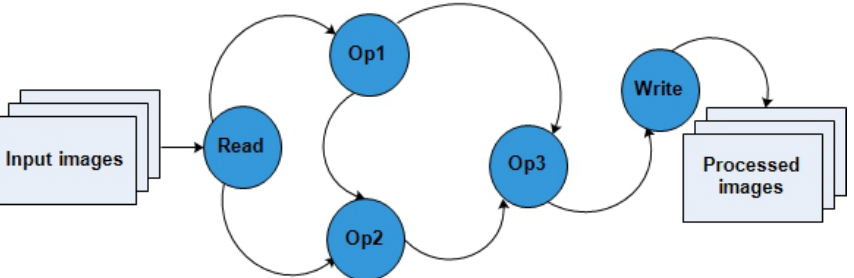
Figure 5. Data processing in the SNAP GPF tool. Op1, Op2, and Op3 represent the operators.